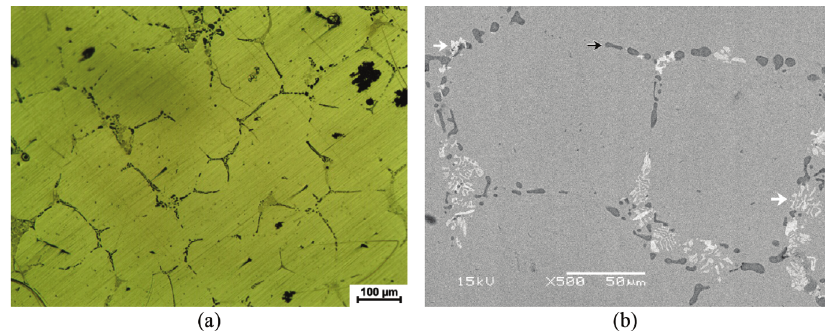
Figure 2: (a) LM and (b) SEM micrographs showing the cast structure of A7075 alloy.